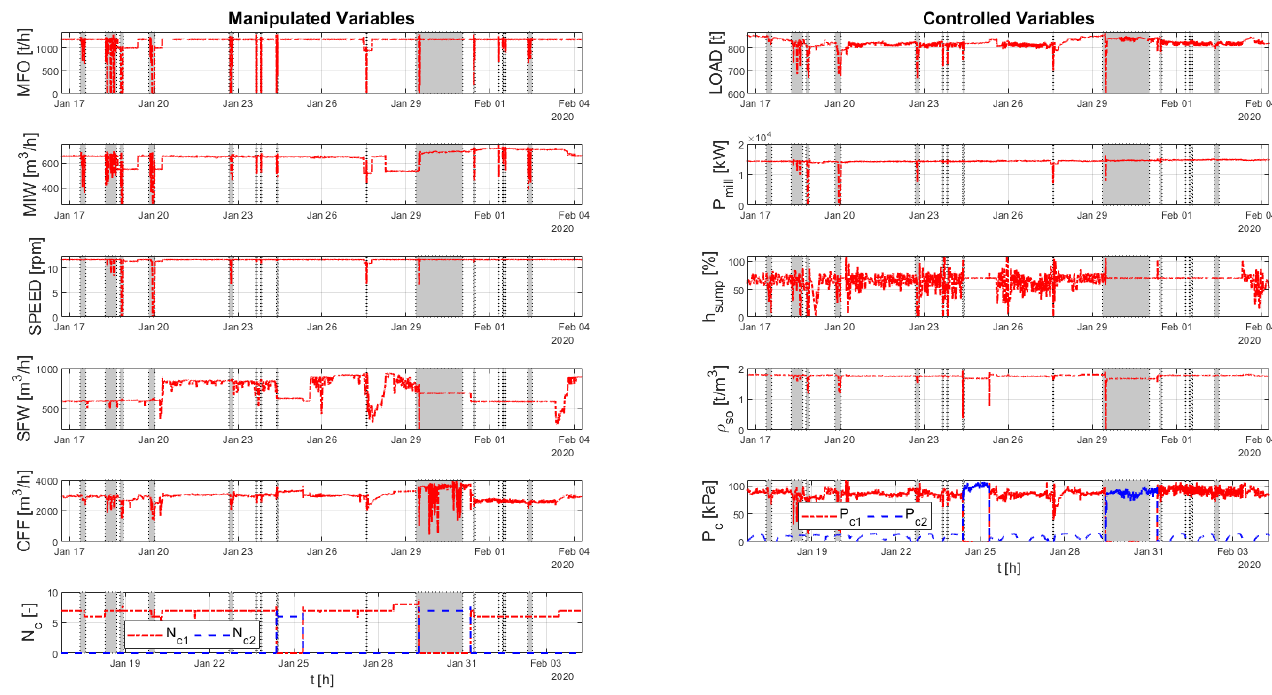
Figure 7. MVs and CVs for the DQA data.